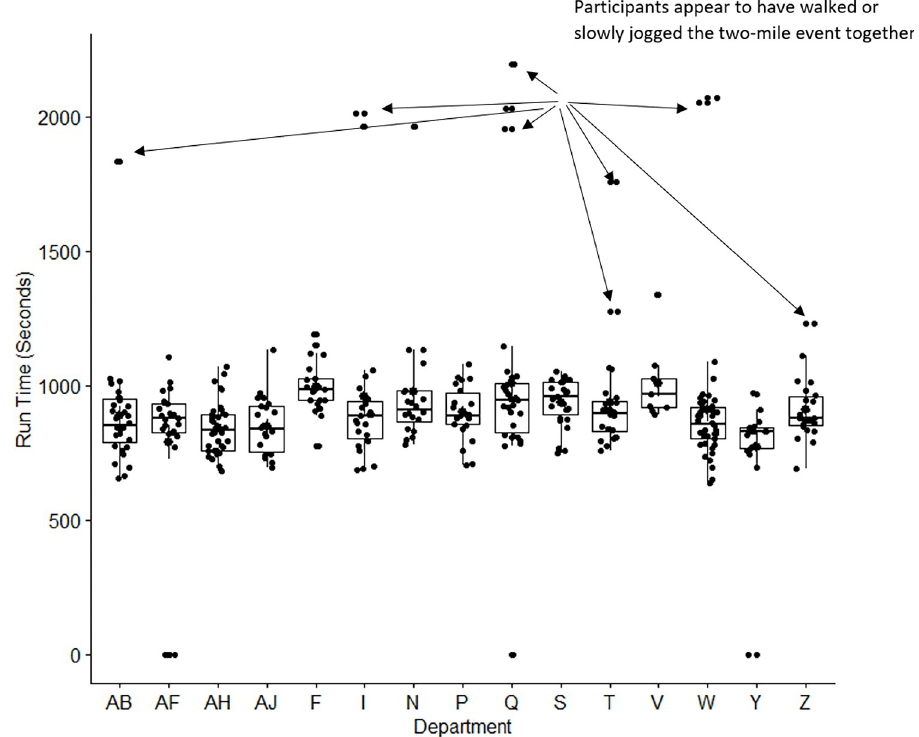
Fig 2. A box plot with the distribution of times on the two-mile run event by department. The pairs of individuals achieving the exact same run-time suggests the pair were walking or slowly jogging together.